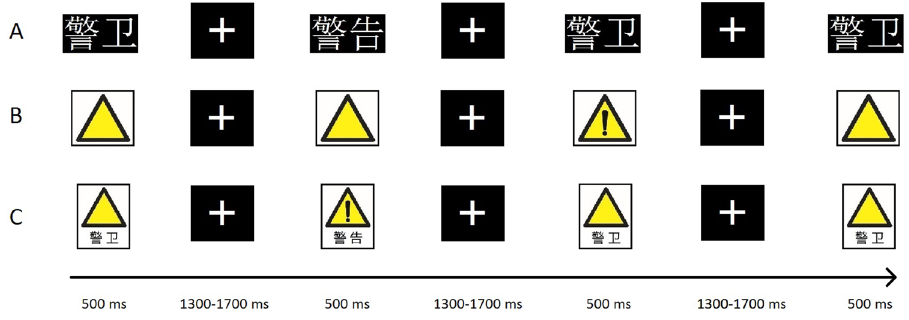
Figure 2. Experimental